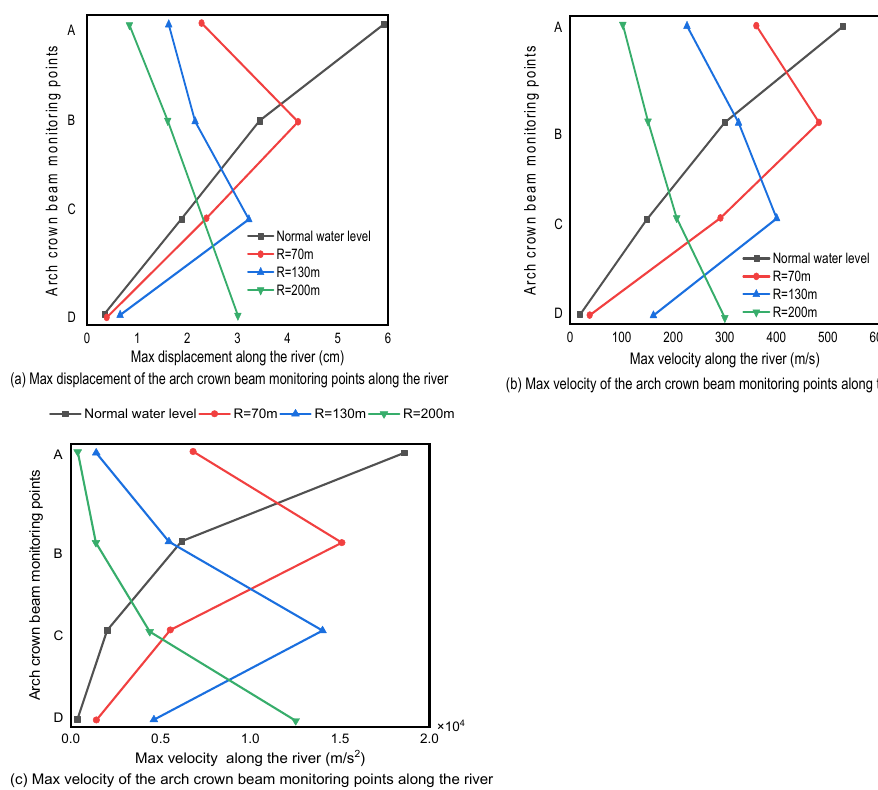
Figure 24. Dynamic response of arch crown cantilever monitoring points in front of the dam at various water levels.